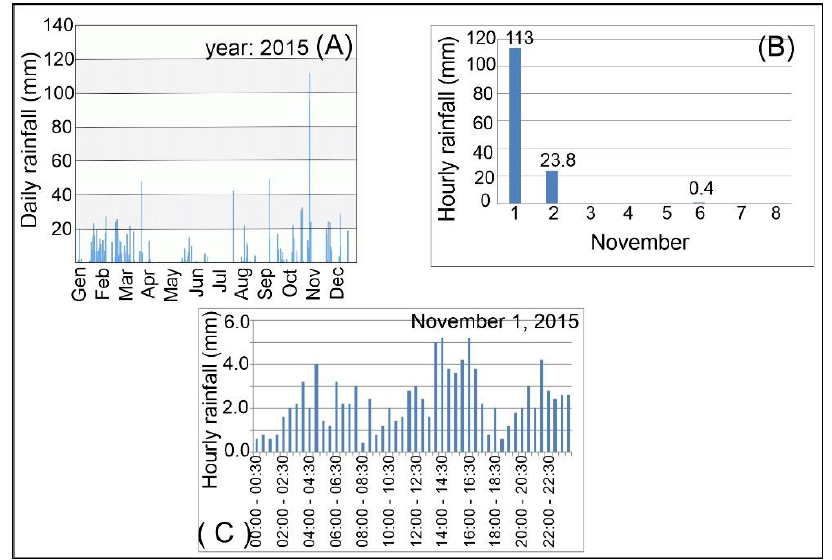
Figure 14. The bar diagrams show daily ( A ), cumulative ( B ) and hourly rainfall ( C ), respectively. Source: own elaboration on the basis of data registered by the hydrometric station of Regional Agency for Environmental Protection of Calabria.